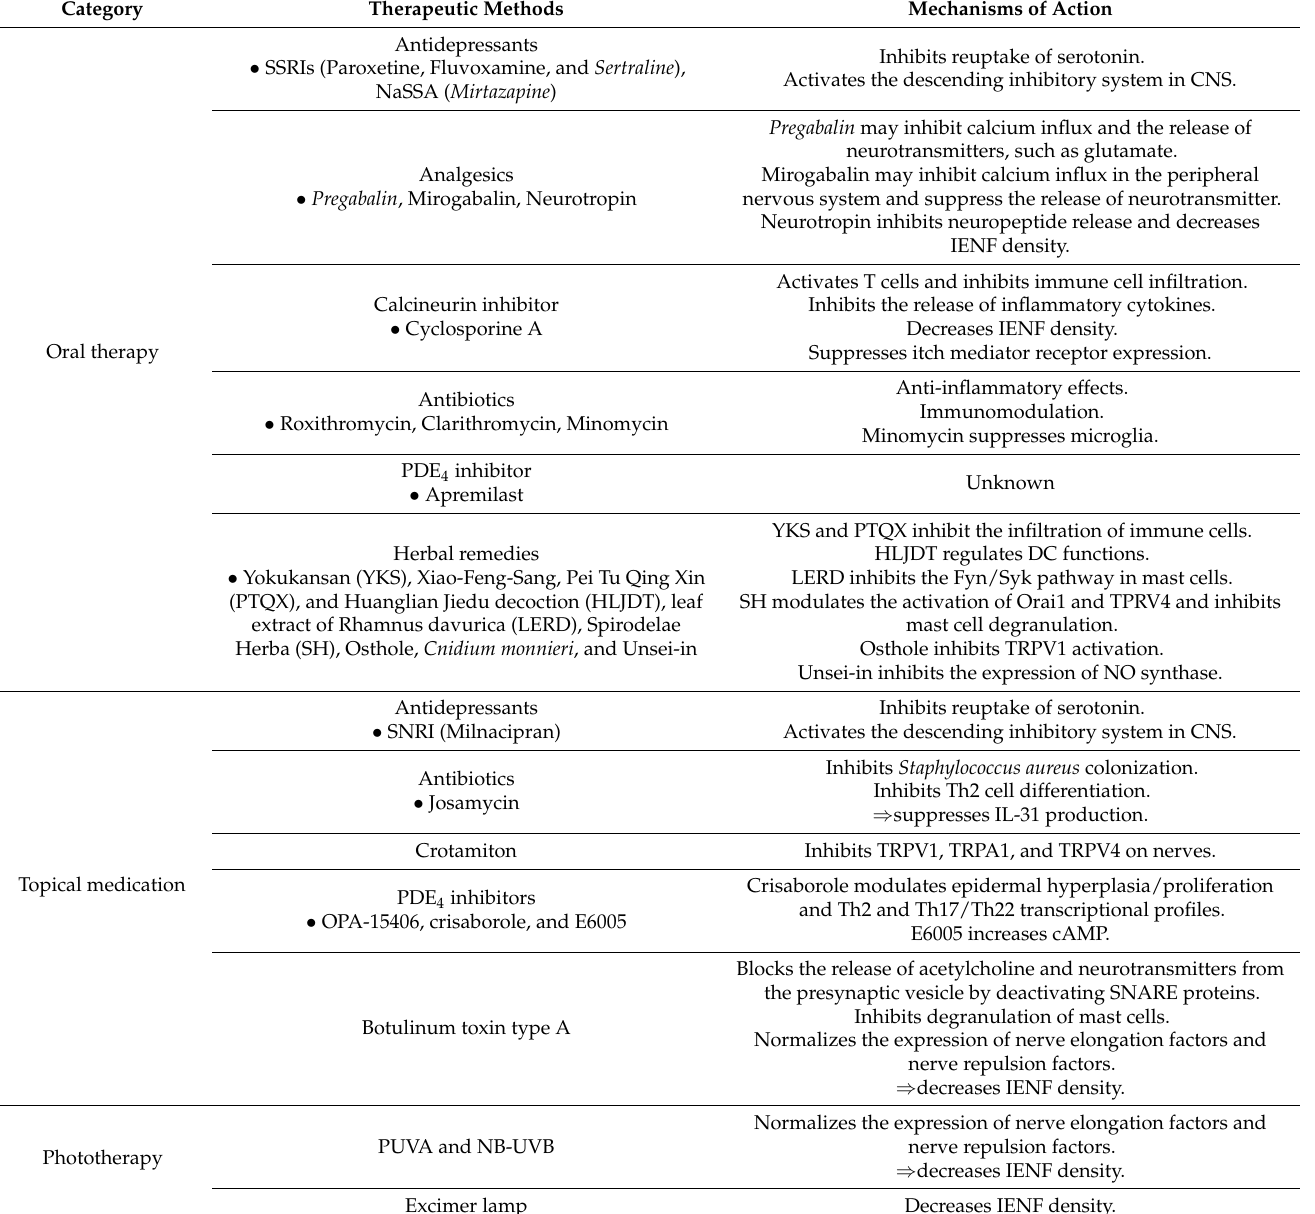
Table 1. Therapeutic methods for troublesome